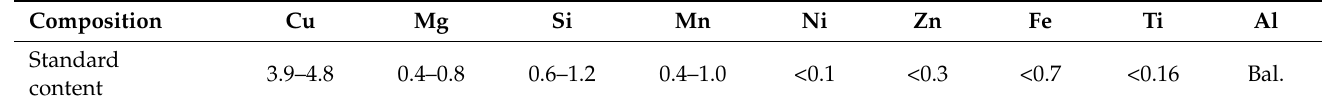
Table 1. Chemical composition (wt%) of 2A14-T6 aluminum alloy.